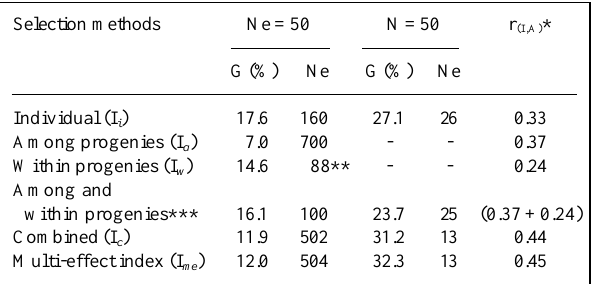
Table III - Estimates of genetic gain (G) in rubber production using different selection methods based on an effective population size (Ne) of 50, and 50 selected individuals (N) in three-year-old progenies of Hevea brasiliensis .